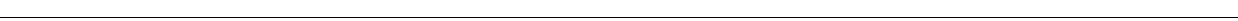
Figure 1 | POP2 expression ameliorates inflammation in vivo . ( a ) Immunohistochemical staining of CD68 in red and POP2 in brown in inflamed human lung tissue (left and middle) showing the original magnification (cid:3) 10 (left, scale bar, 50 m m) and (cid:3) 40 (middle, scale bar, 10 m m) and human RA synovial lining showing the original magnification (cid:3) 10 (right, scale bar, 50 m m). ( b ) Analysis of POP2 expression by flow cytometry in peripheral blood cell populations from WT and POP2 TG mice using SmartFlares ( n ¼ 2). ( c ) POP2 expression in peripheral blood-derived macrophages isolated from WT and POP2 TG mice by immunoblot. Membranes were stripped and re-probed with a b -Actin antibody as loading control ( n ¼ 5). ( d ) In vivo imaging of MPO activity of infiltrating neutrophils with a luminescent probe in response to i.p. injection with MSU crystals (3mg; þ ) or PBS ( (cid:2) ) in WTand POP2 TG mice after 4h (left, scale bar, 1cm), and quantification of the luminescent counts (right; n ¼ 9). ( e ) Cytokine ELISA and ( f ) immunoblot for extracellular ASC particles in cleared peritoneal exudates of WT and POP2 TG mice 8h after MSU injection ( n ¼ 10–13). ( g ) In vivo imaging of MPO activity correlating to MSU-induced neutrophil infiltration into air pouches 7h after MSU (3mg per airpouch; þ ) or PBS ( (cid:2) ) injection in WTand POP2 TG mice (left, scale bar, 1cm) and signal quantification (right; n ¼ 9–10). ( h ) FACS analysis of infiltrating cells in airpouch lavage exudates of WTand POP2 TG mice 8h after MSU quantification (right; n ¼ 11). ( j , k ) Cytokine ELISA and LDH quantification of ( j ) cleared peritoneal exudates and ( k ) serum of WTand POP2 TG mice 4h